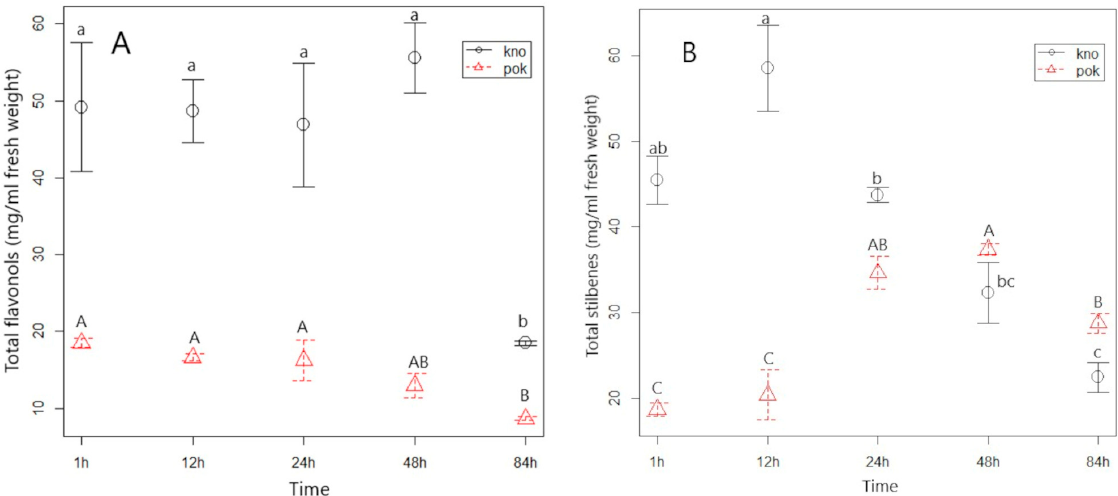
Figure 3. Average contents of total analyzed flavonols ( A ) and stilbenes ( B ) with standard error (mg/mL) in the aqueous extract of American pokeweed (pok) and Japanese knotweed (kno) with different times of extraction. Different small letters indicate statistically significant differences in the content of each phenolic group between different extraction times for Japanese knotweed (T1–T5) ( p ≤ 0.05) and different capital letters indicate statistically significant differences in the content of each phenolic group between different extraction times for American pokeweed (T1–T5) ( p ≤ 0.05). T1 represents a time of 1 h, T2 a time of 12 h, T3 a time of 24 h, T4 a time of 48 h, and T5 a time of 84